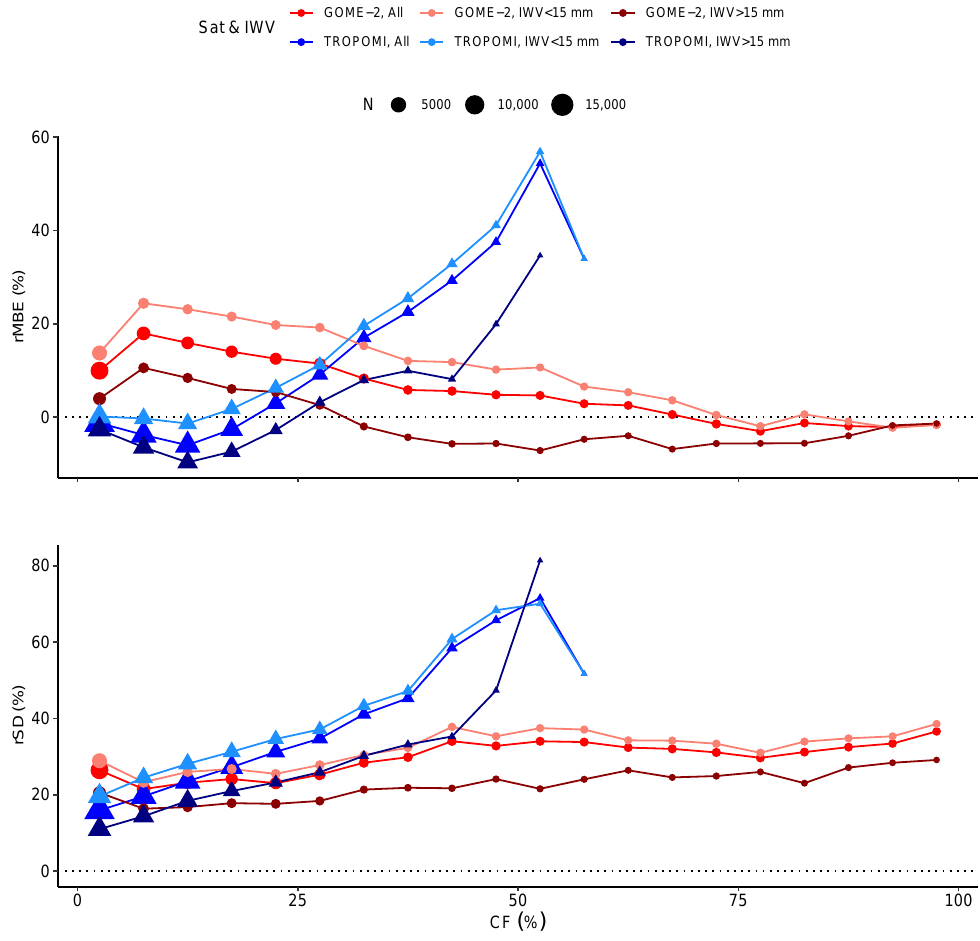
Figure 6. rMBE and rSD against CF in bins of 5 %. Data are also divided by high IWV (darker colors), all data (regular colors) and low IWV (light